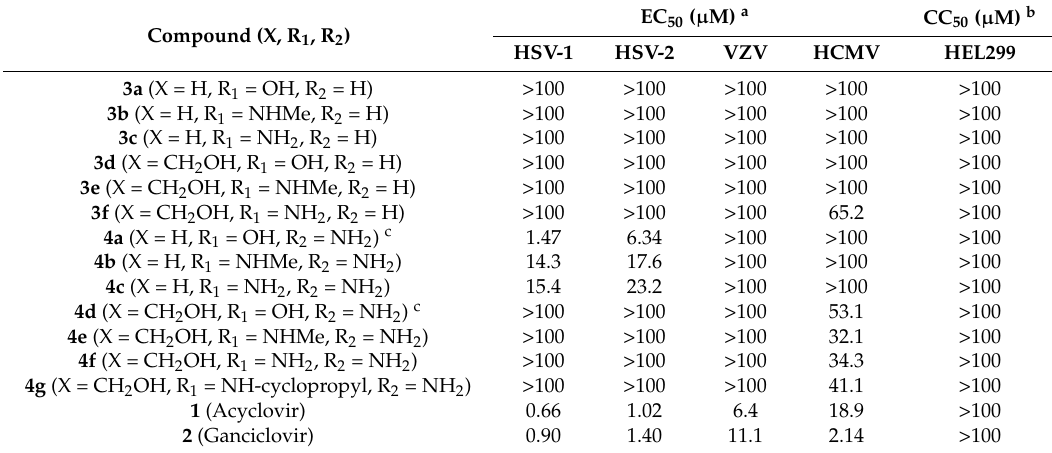
Table 1. Antiviral activities of all the final nucleosides 3a - f and 4a - g